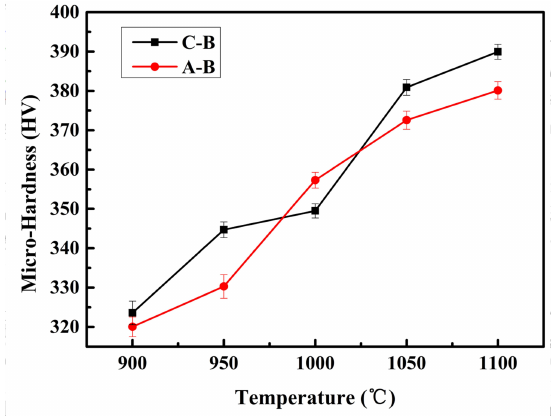
Figure 8. The Vickers hardness values of samples sintered at different temperature.